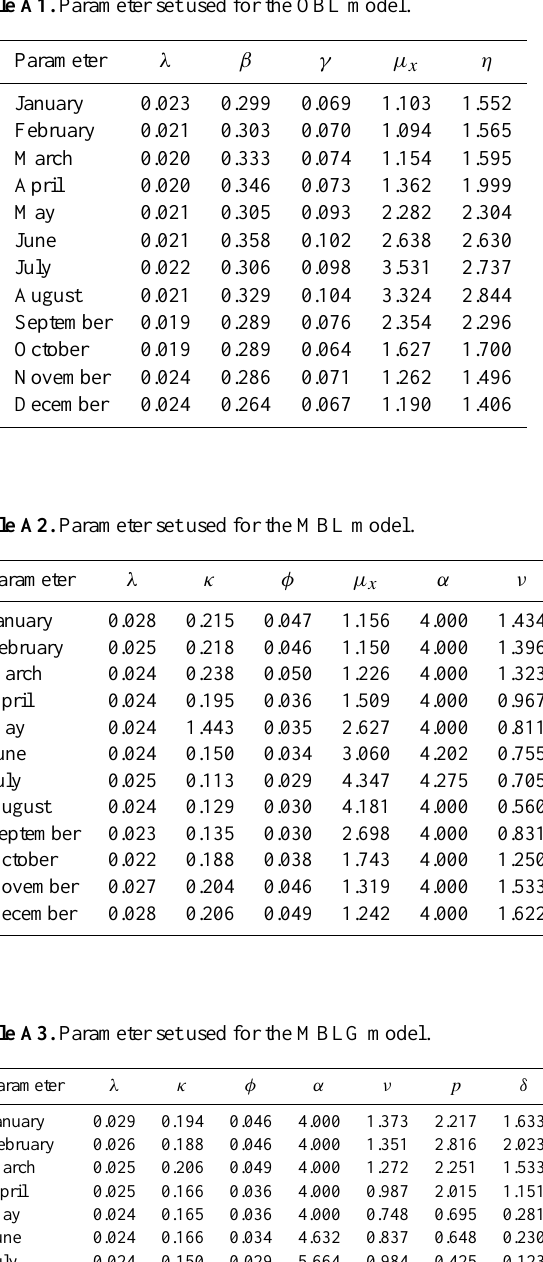
Table A1. Parameter set used for the OBL model.